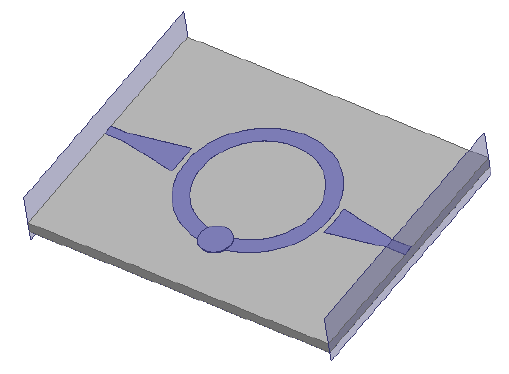
Fig. 3. 3D-model of a microstrip ring resonator with cavity resonator